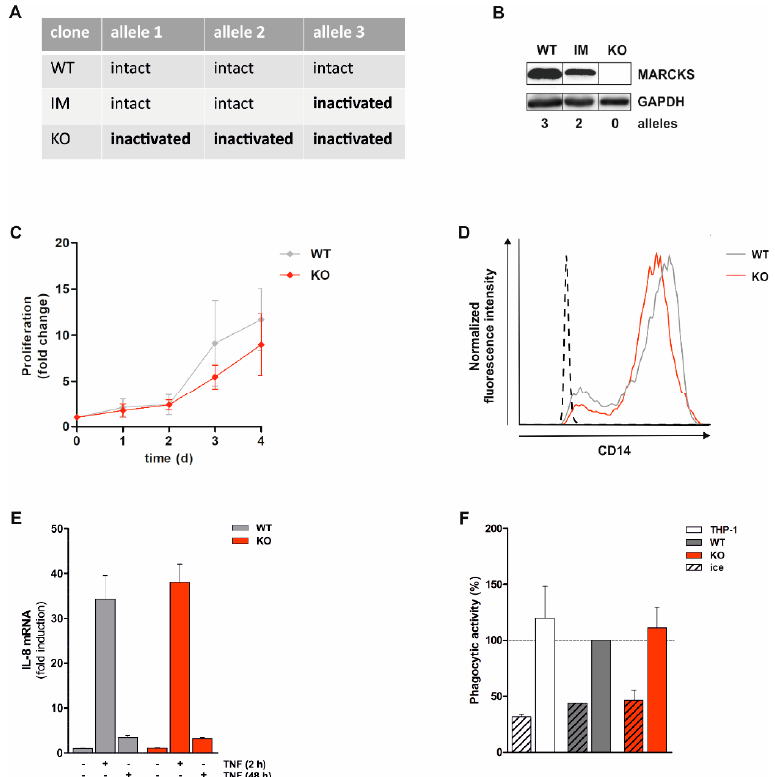
Figure 1. Generation and characterization of MARCKS KO cells. Monocytic THP-1 cells were modified using the CRISPR/Cas9 technique to generate MARCKS KO cells. The resulting WT, IM, and KO clones were characterized in terms of allelic integrity, MARCKS protein expression, proliferation, monocytic differentiation, cytokine expression, and phagocytosis. ( A ) The table summarizes the condition of the 3 MARCKS alleles in MARCKS WT, IM, and KO clones as determined by Sanger sequencing. ( B ) MARCKS protein levels were detected in whole cell extracts of MARCKS WT, IM, and KO clones. Loading control: GAPDH (representative experiment, n > 3). ( C ) MARCKS WT and KO cells were synchronized for 3 d in minimal growth medium. Afterwards, cells were transferred into standard growth medium and cell numbers were counted daily (mean ± SD, n = 3). ( D ) Following calcitriol-induced differentiation (100 nM) for 3 d, CD14 expression on the cell surface was assessed using flow cytometry (dashed line: isotype control; representative experiment, n > 10). ( E ) Five-day calcitriol-differentiated MARCKS WT and KO cells were incubated with 80 ng/mL TNF for 2 h or 48 h (TNF added at day 3), and the IL-8 mRNA level was determined by qRT-PCR. The IL-8 level in differentiated control cells (i.e., in the absence of TNF) was set as 1 (mean ± SD, representative experiment determined in triplicates; n = 3). ( F ) Five-day differentiated THP-1 as well as MARCKS WT and KO cells were incubated with opsonized eFlour670-labeled bacteria for 1 h (>5 bacteria per cell; mean ± SD, representative experiment, determined in duplicates; n = 4). During the incubation with bacteria, control cells were kept on ice. Phagocytosis was analyzed using flow cytometry. The phagocytic activity (i.e., the geometric mean fluorescence intensity) of living and bacteria-positive cells was calculated, and the value obtained in differentiated MARCKS WT cells was set as 100% (dashed